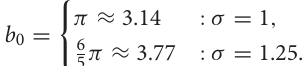
(see legend). The 1 , 1.25 ∈ { }